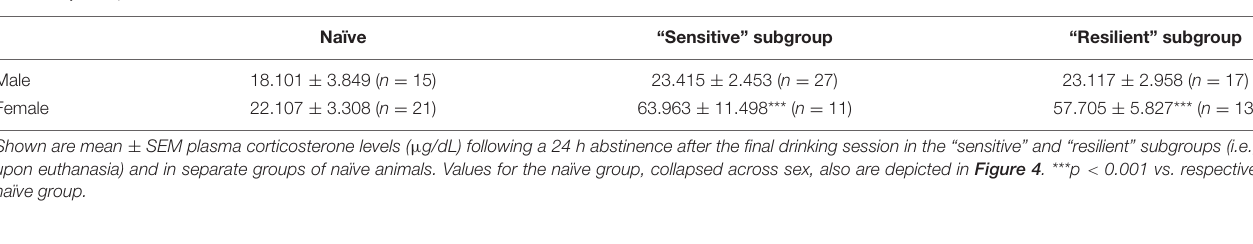
TABLE 1 | Final plasma corticosterone